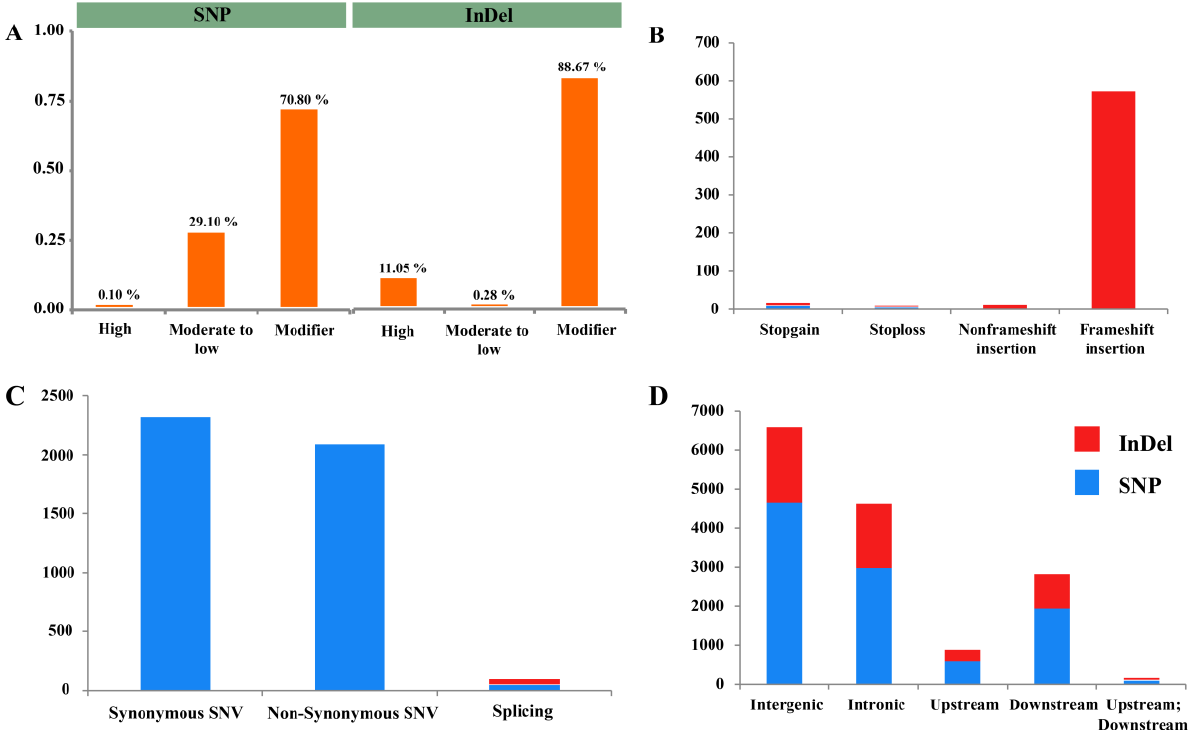
Figure 4. InDel and SNP effects by impact and subclassification: ( A ) number of InDel and SNP ef- fects by impact, ( B ) high impact, ( C) moderate to low impact, ( D) modifier impact.